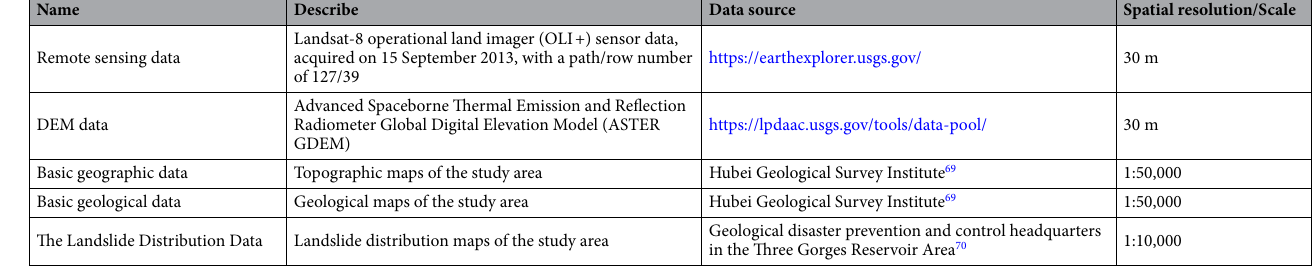
Table 1. The data source